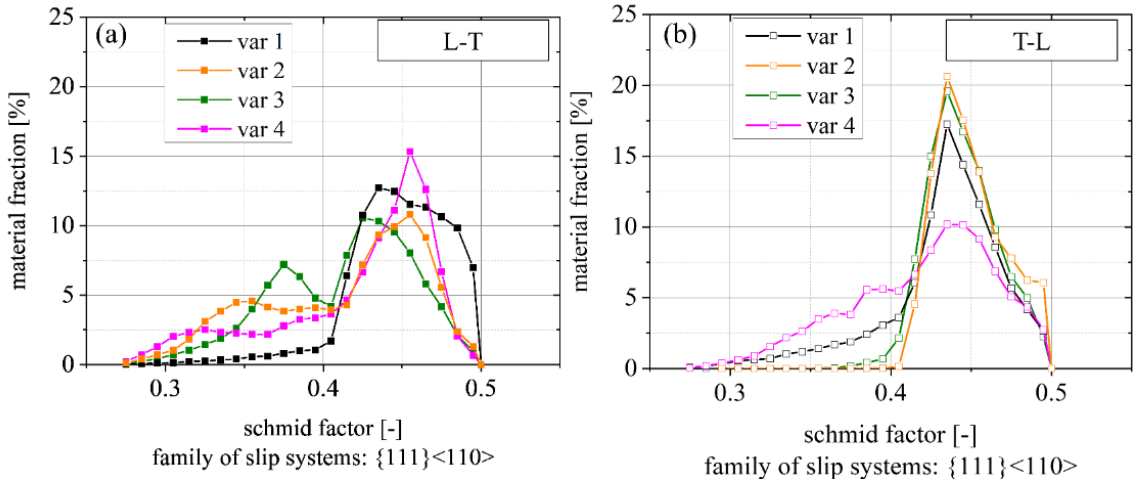
Figure 5. Schmid factors for {111} <110> family for load direction parallel to ( a ) L and ( b ) T directions.